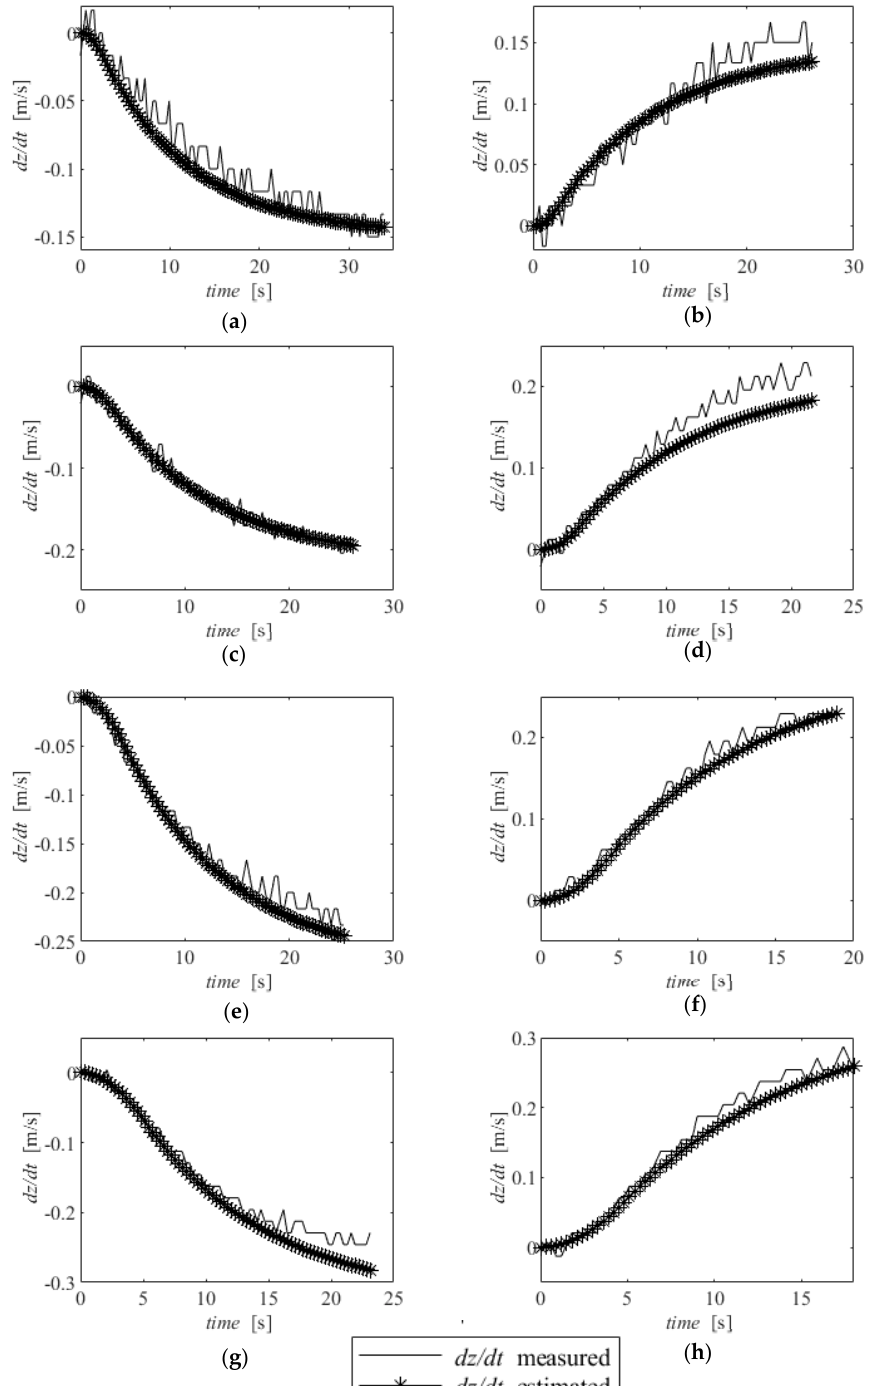
Figure 8. Identification results for experiments 2: ( a ) x : 0 → 9 (mm), ( b ) x : 0 → − 9 (mm), ( c ) x : 0 → 13 (mm), ( d ) x : 0 → − 13 (mm), ( e ) x : 0 → 17 (mm), ( f ) x : 0 → − 17 (mm), ( g ) x : 0 → 21 (mm), ( h ) x : 0 → − 21 (mm).